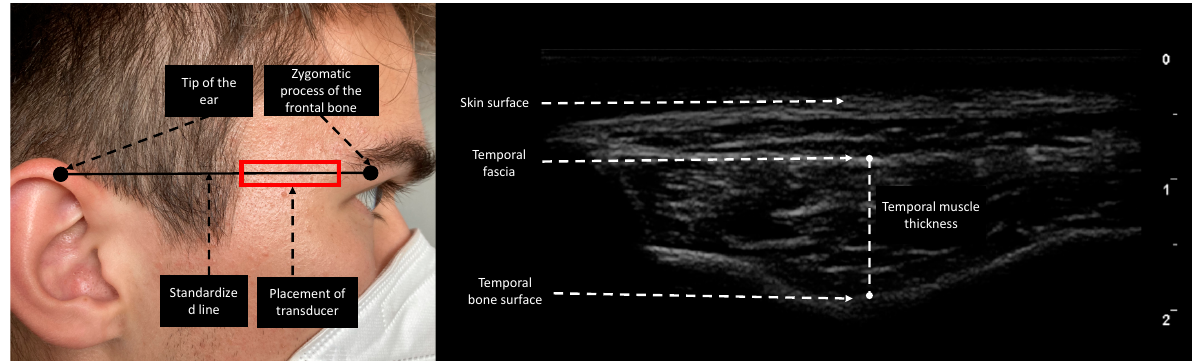
Figure 1. Measurement site of the temporal region. The reference line is the horizontal line connecting the zygomatic process of the frontal bone and the upper edge of the auricula. The transducer was placed rectangular to the skin. TMT was evaluated as the maximal distance between the temporal fascia and temporal bone surface.